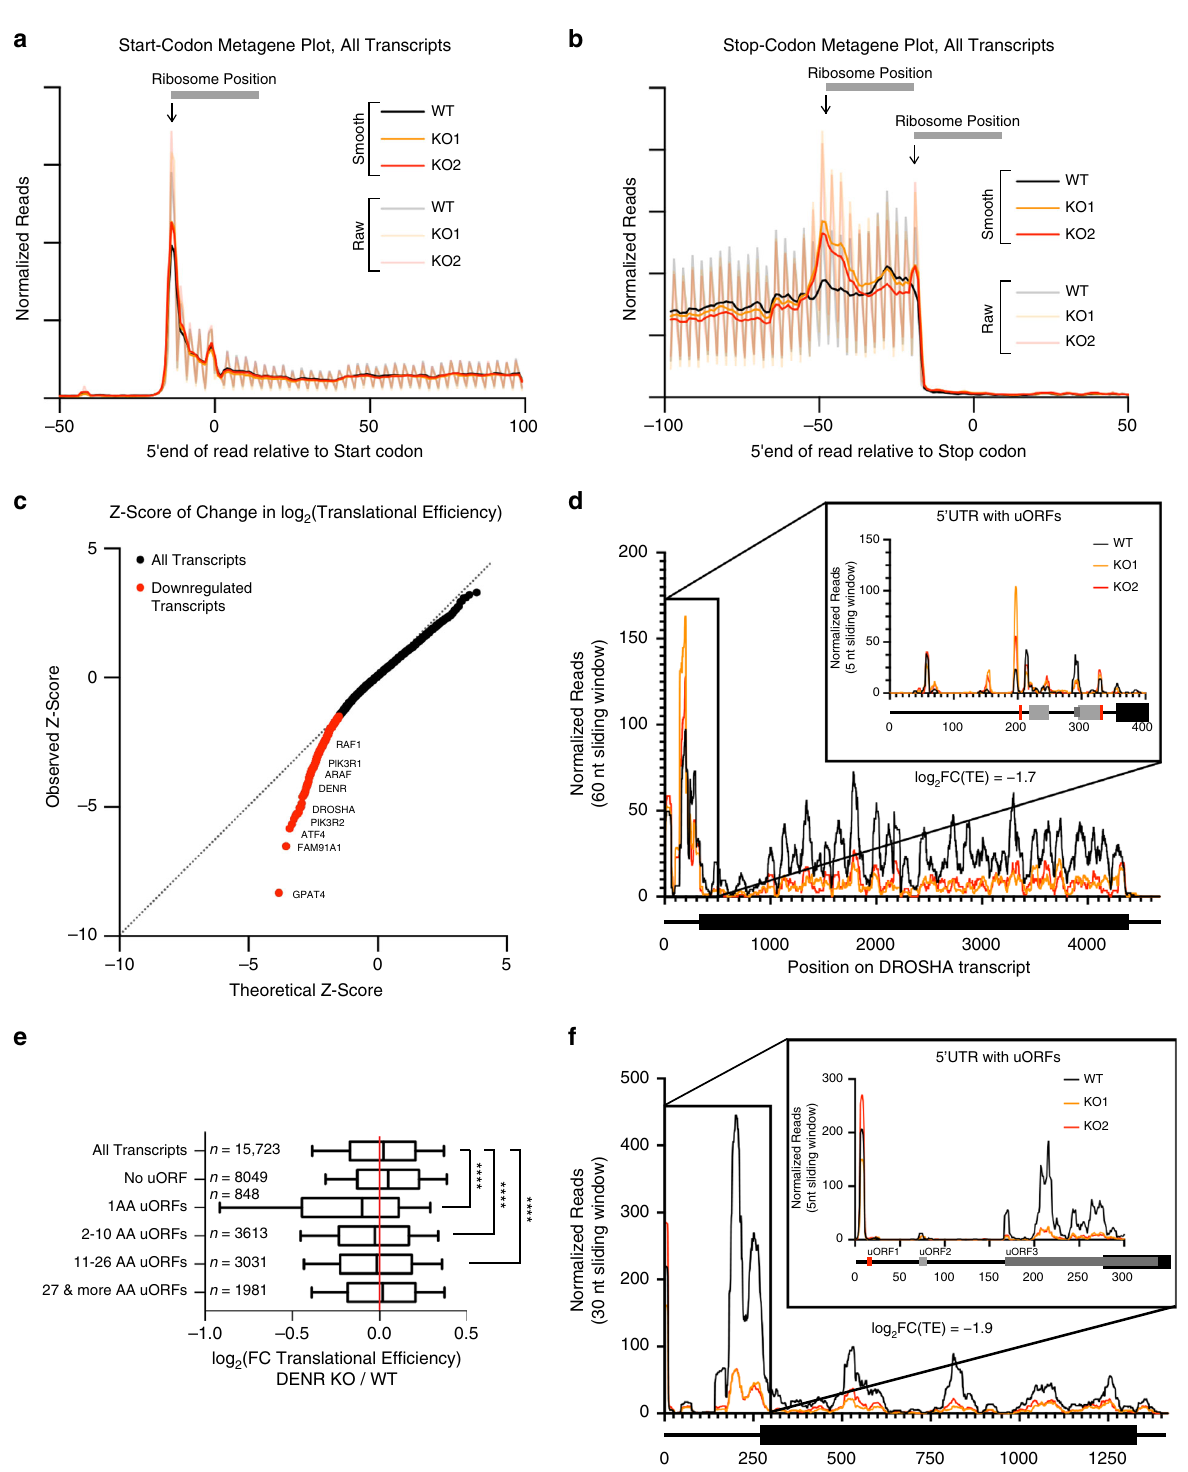
DENR (cid:129) MCTS1 are required for ef fi cient ATF4 translation . To study the involvement of DENR (cid:129) MCTS1 in ATF4 translation, we fi rst assayed ATF4 protein levels in control and DENR KO cells (Fig. 2a). Control HeLa cells have low levels of ATF4, which increase in response to tunicamycin-induced endoplasmic reti- culum (ER) stress (lanes 1 – 2, Fig. 2a). Upon tunicamycin treat- ment, eIF2 α phosphorylation appears to increase only mildly (Fig. 2a, b), probably because p-eIF2 α (Ser51) antibodies